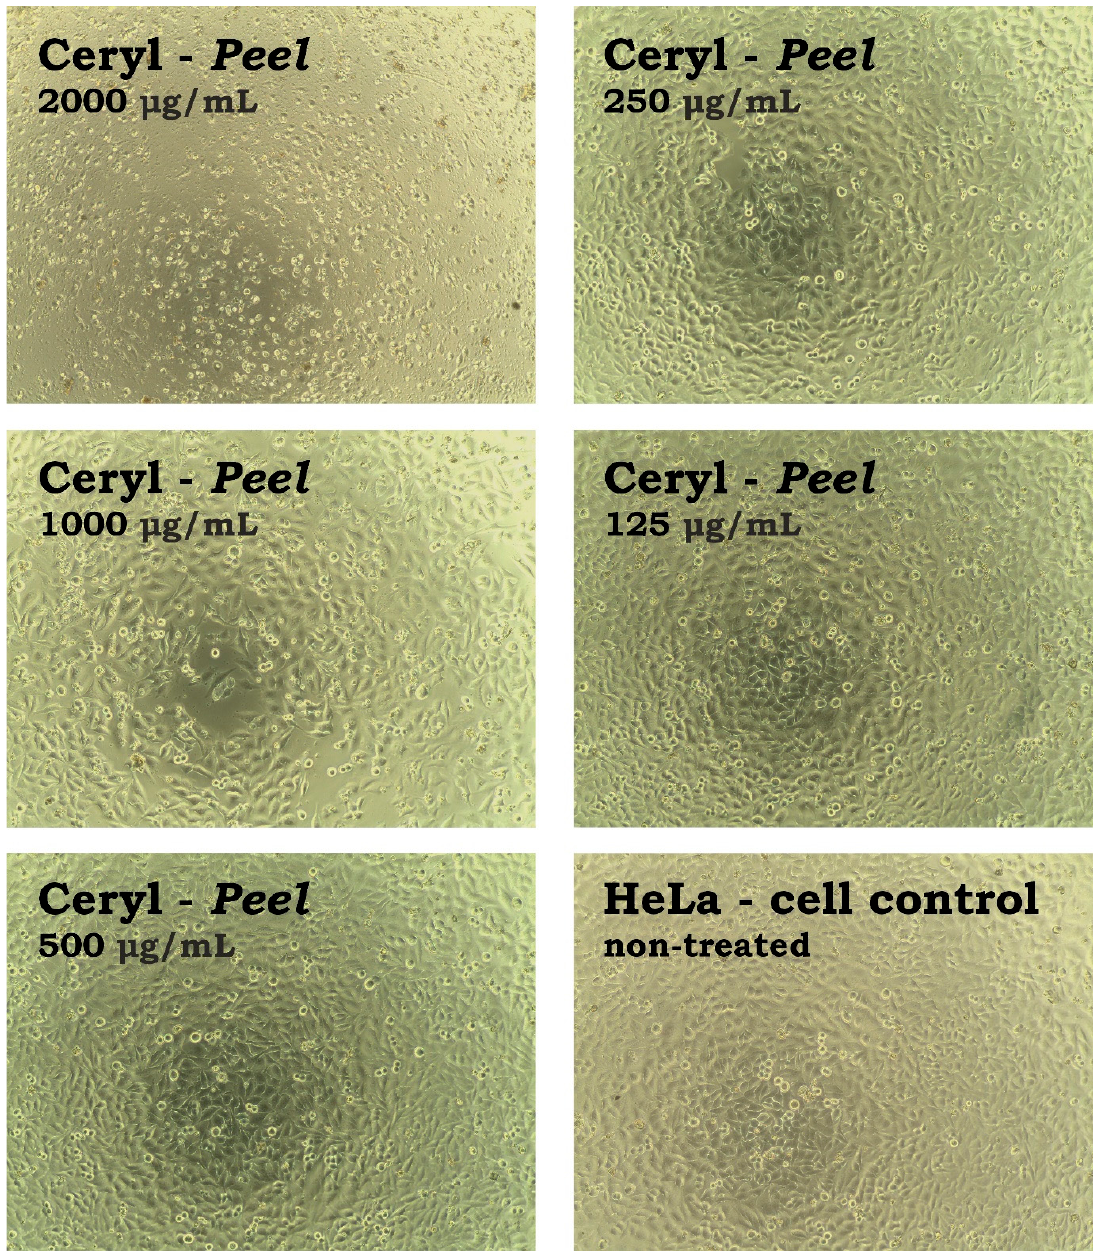
Figure 7. The influence of serial dilutions of extracts from the peel of B. vulgaris Ceryl cultivar on the cell line derived from cervical adenocarcinoma.